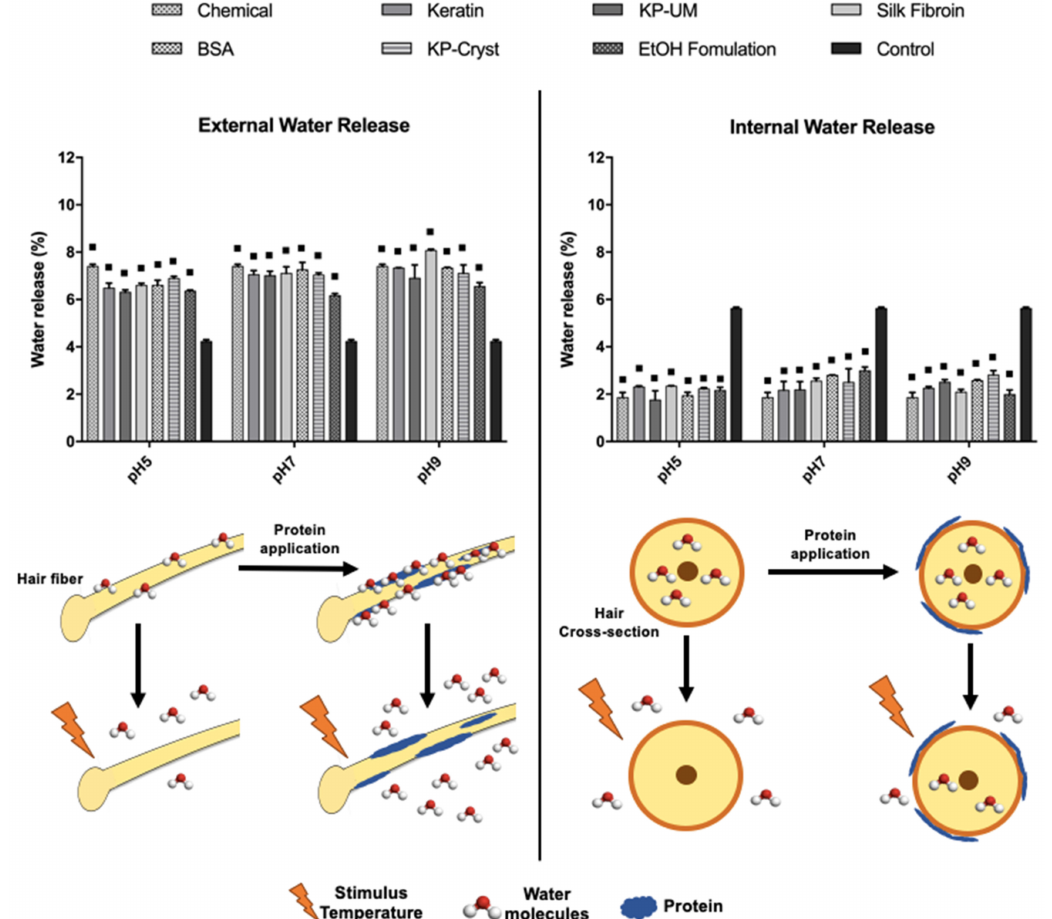
Figure 6. Percentage of external and internal water contents in the hair fibers after treatment with keratin, KP-UM, silk fibroin, BSA and KP-Cryst proteins prepared in phosphate buffer (pH 5, 7 and 9) and BaByliss application for 50 s. Hair treated with a commercial formulation for perming (“Chemical”) and hair curled with the BaByliss after treatment with the ethanolic formulation and phosphate buffers (“EtOH formulation”), or without any treatment (“Control”) were used as controls. The values represent the mean ± SD of two measurements. The data were analyzed by Dunnett’s multiple comparison test: p -value ≤ 0.0001 ( (cid:4) ) compared to the “Control”